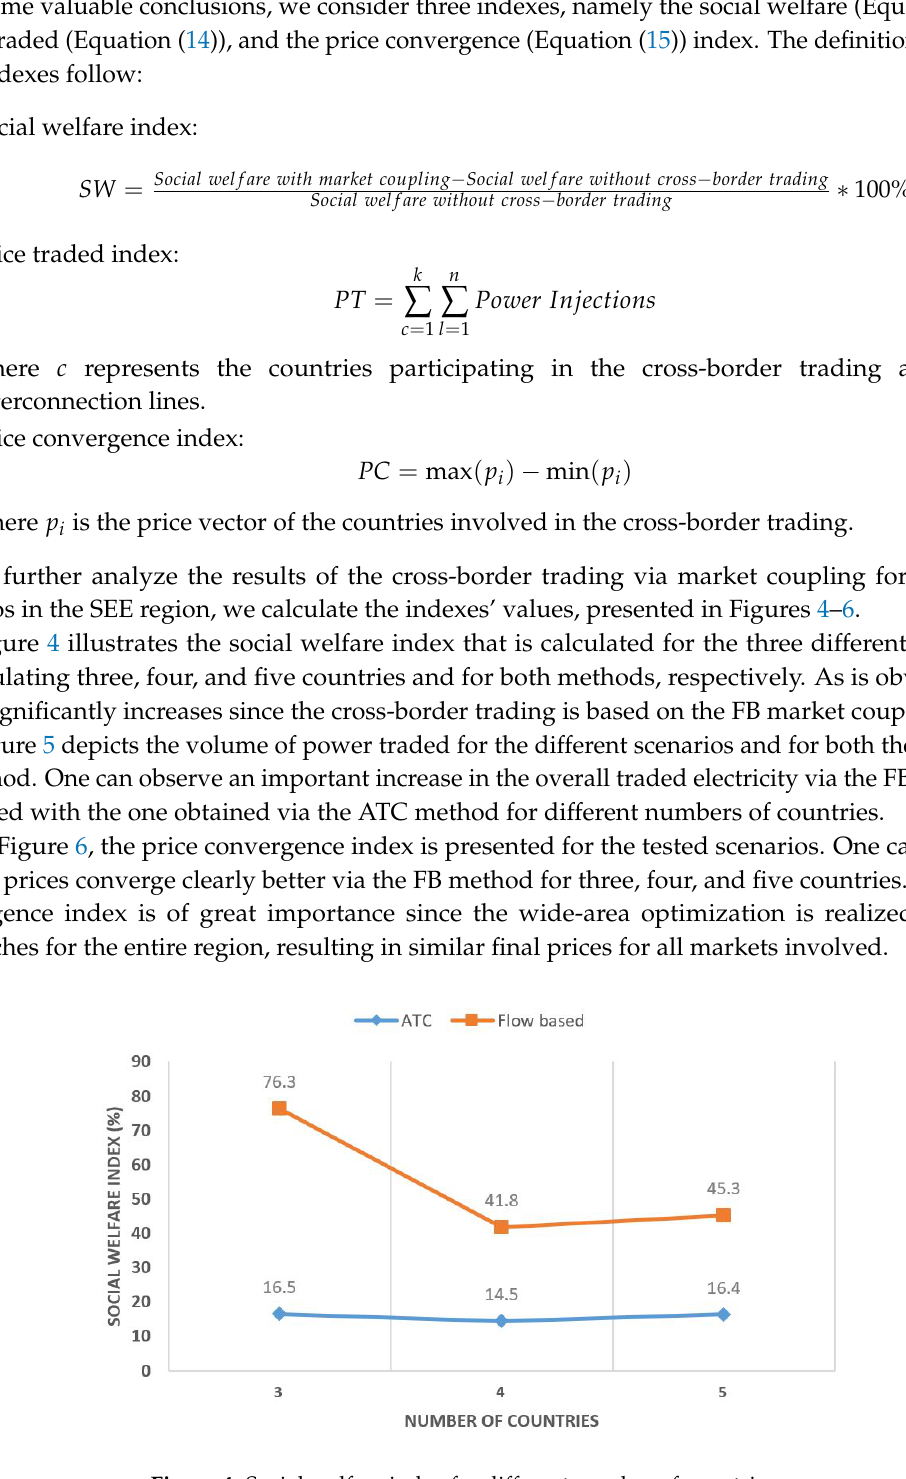
Figure 4. Social welfare index for different number of